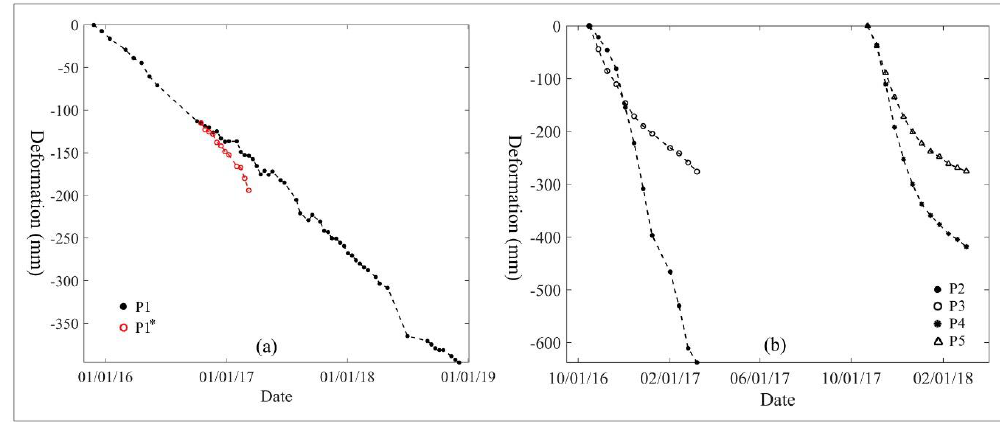
Figure 10. Deformation time series of six points whose locations are marked as triangles in Figure 8a,c,d: ( a ) point P1 and P1*; ( b ) point P2, P3, P4 and P5. Please note, P1 and P1* refer to the same location.